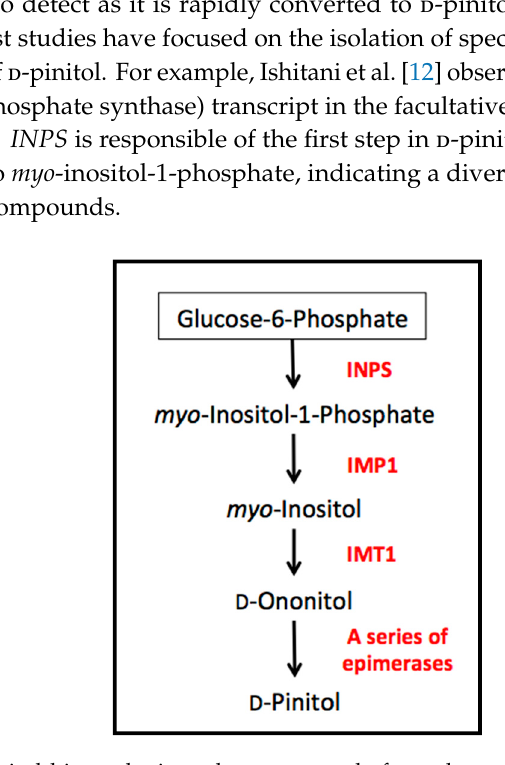
Figure 1. The D-pinitol biosynthetic pathway proceeds from the precursor glucose-6-phosphate. Abbreviations—INPS: myo -inositol-1-phosphate synthase; IMP1: inositol monophosphatase; IMT1: myo -inositol- O -methyltransferase.